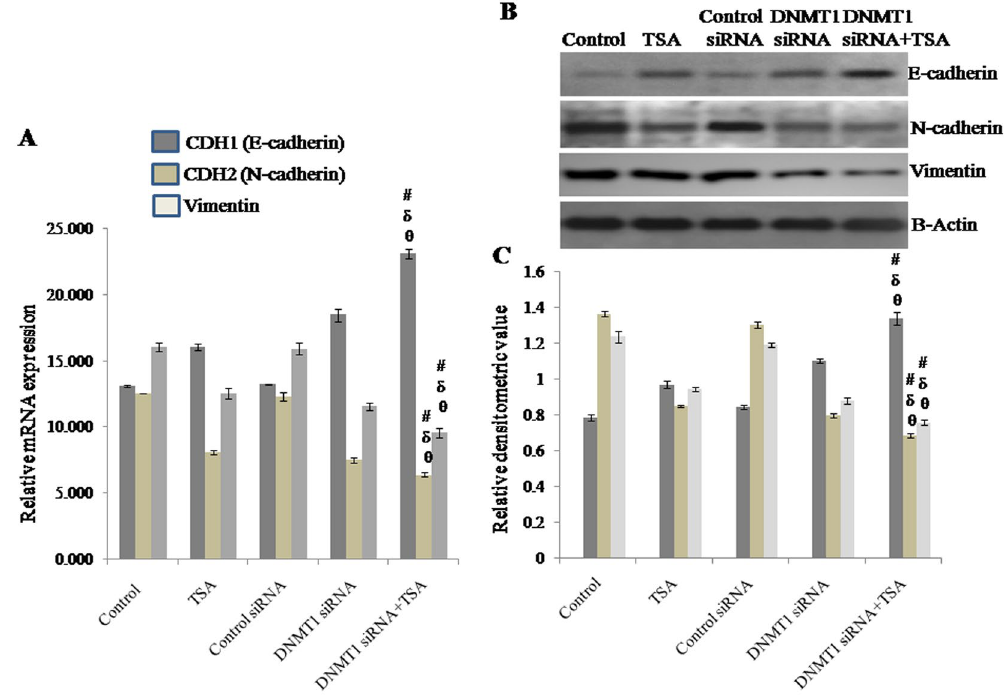
Figure 9. Expression of E-cadherin, N-cadherin and vimention analyzed by ( A ) qRT-PCR using GAPDH as internal control and expressed in terms of relative mRNA expression. Western blot analysis of E-cadherin, N-cadherin and vimention using β-actin as loading control, showing ( B ) effect of knockdown of DNMT1 and inhibition of HDAC1 & HDAC2 synergistically or due to either of any one on EMT, ( C ) relative densitometric value obtained from densitometric scanning after normalization with β-actin. The representative blots of replicates were presented here. The full-length original images (cropped) of representative blots were presented in the supplementary Fig. S8 of Supplementary information file. Data was represented as mean ± SEM., n = 3, p < 0.05. #, δ and θ represent; compared to control group, TSA treated group and DNMT1 siRNA transfected group